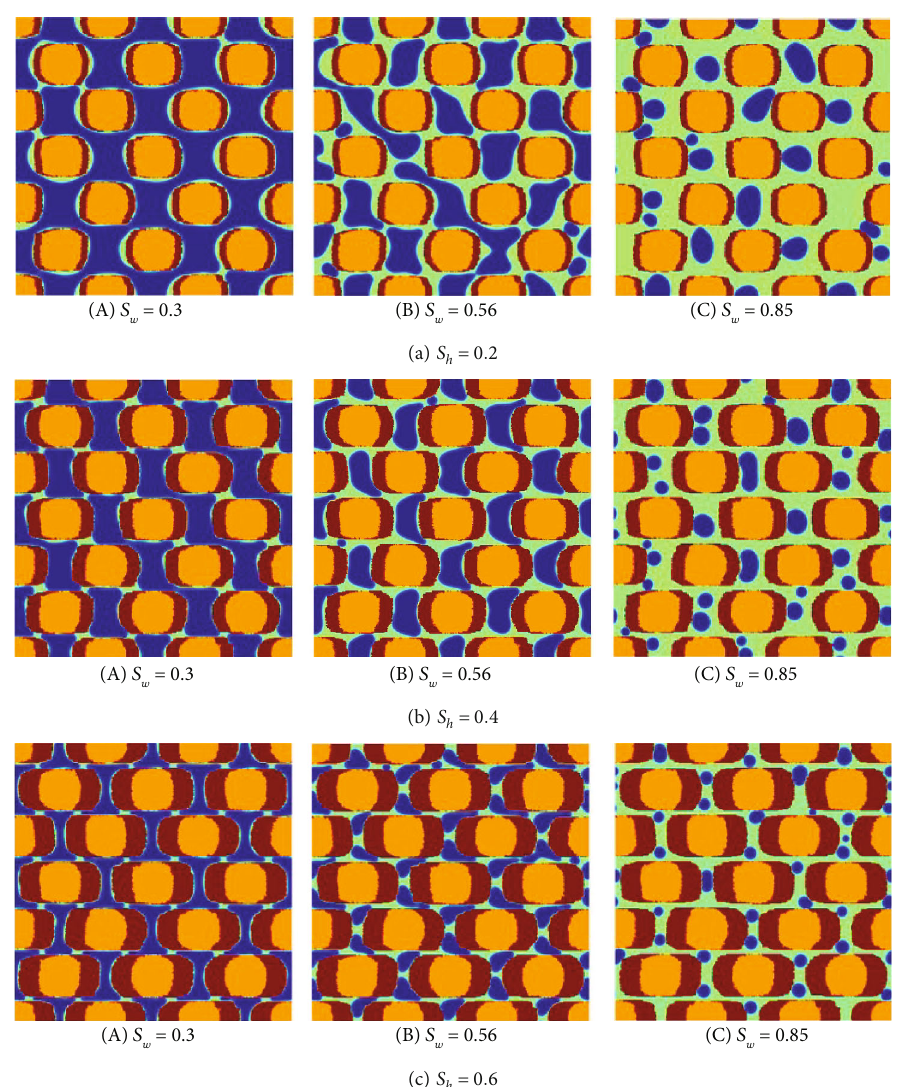
Figure 12: Gas and water dual-phase distribution patterns in S shown as light green, solid particles as orange, and hydrate as